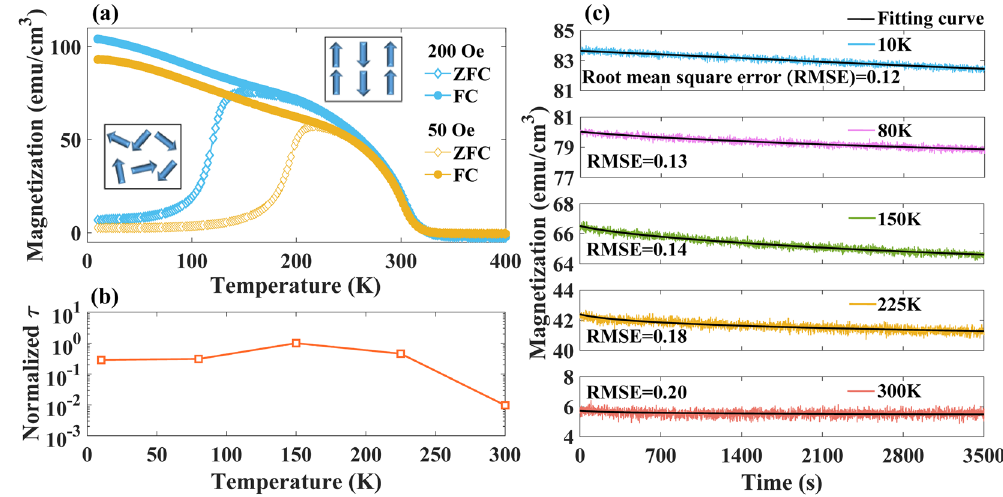
Figure 1. ( a ) Temperature dependence of magnetization of LFCS film measured by ZFC and FC procedures under the applied magnetic fields of 50 Oe and 200 Oe. ( b ) Normalized τ in FC procedure at 10, 80, 150, 225, and 300 K under the applied magnetic fields of 100 Oe. ( c ) The magnetic relaxation data with the fitting curve at 10, 80, 150, 225, and 300 K under the applied magnetic fields of 100